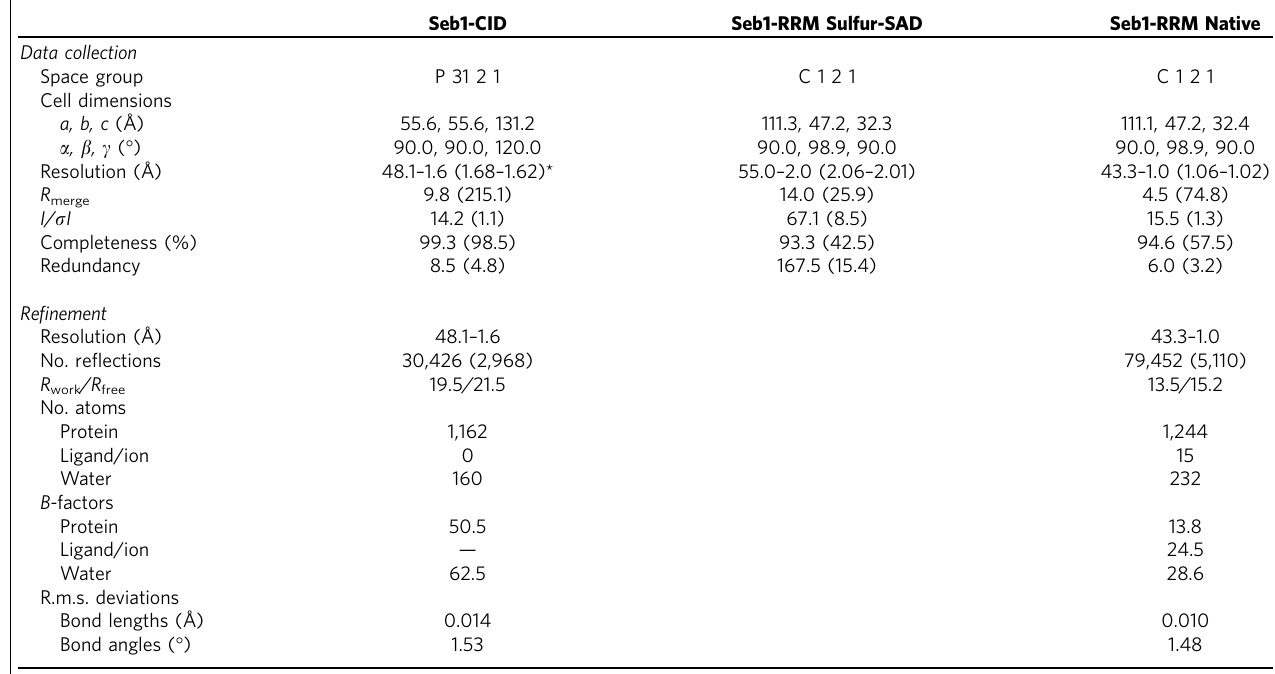
Table 2 | Data collection and refinement statistics.